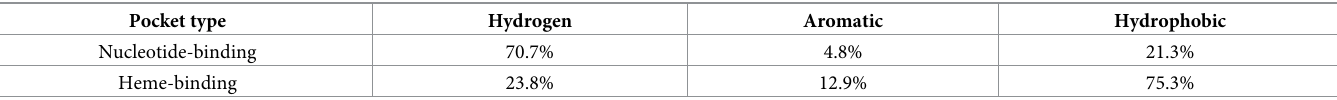
Table 3. Percentage of binding residues forming specific interactions with ligands. Binding residues are identified by the class-activation map analysis to be part of the highly discriminative regions of nucleotide- and heme-binding pockets. Three types of interactions reported by the LPC program are considered, hydrogen bonds, aro- matic and hydrophobic